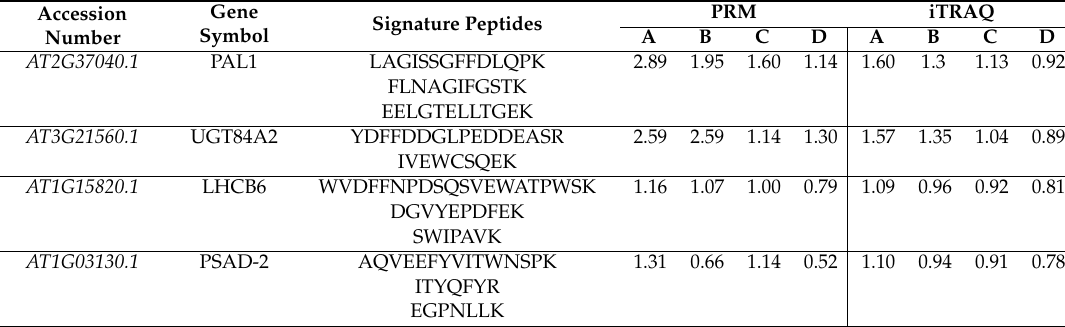
Table 6. Representative protein quantitative confirmation with PRM analysis.